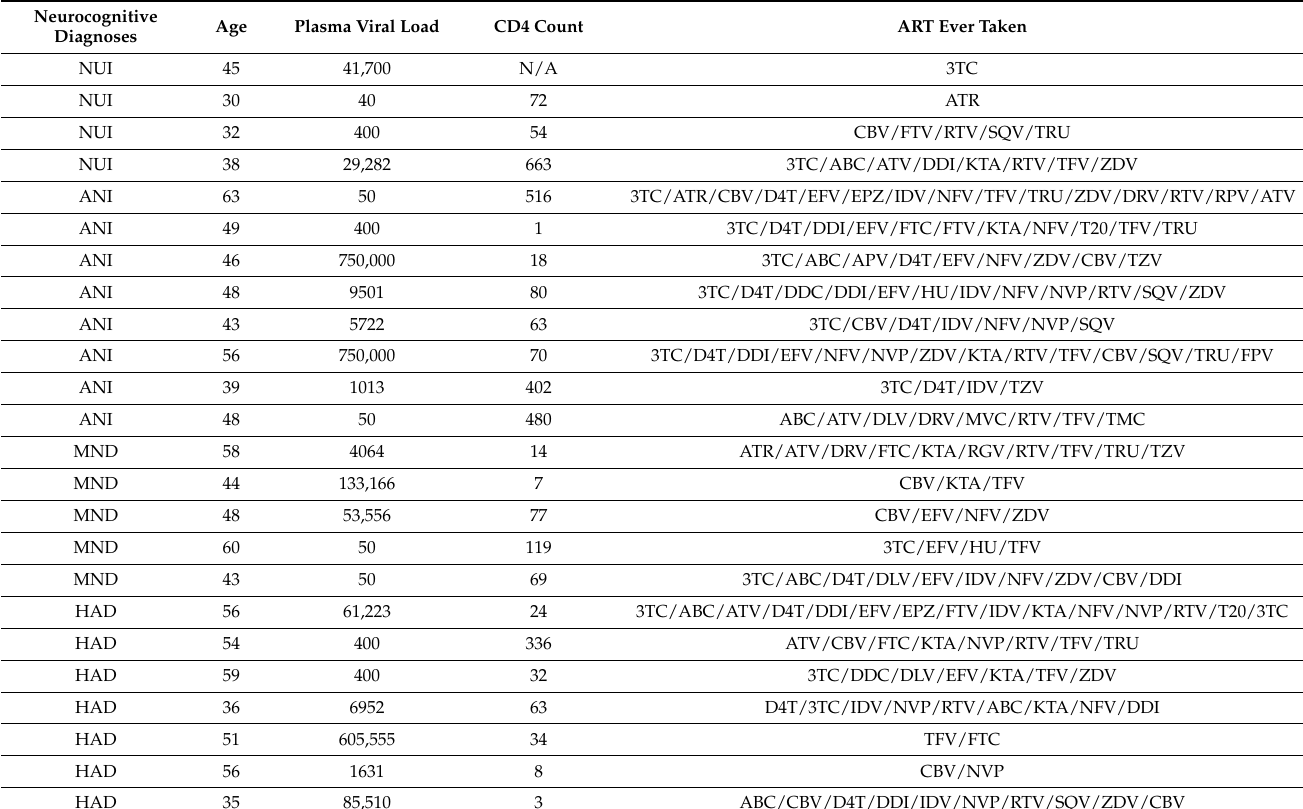
Table 1. Clinical characteristics of study population. Abbreviations: NUI, Neurocognitively unimpaired; ANI, Asymp- tomatic neurocognitive impairment; MND, Minor neurocognitive dysfunction; HAD, HIV-associated dementia; CD4, cluster of differentiation